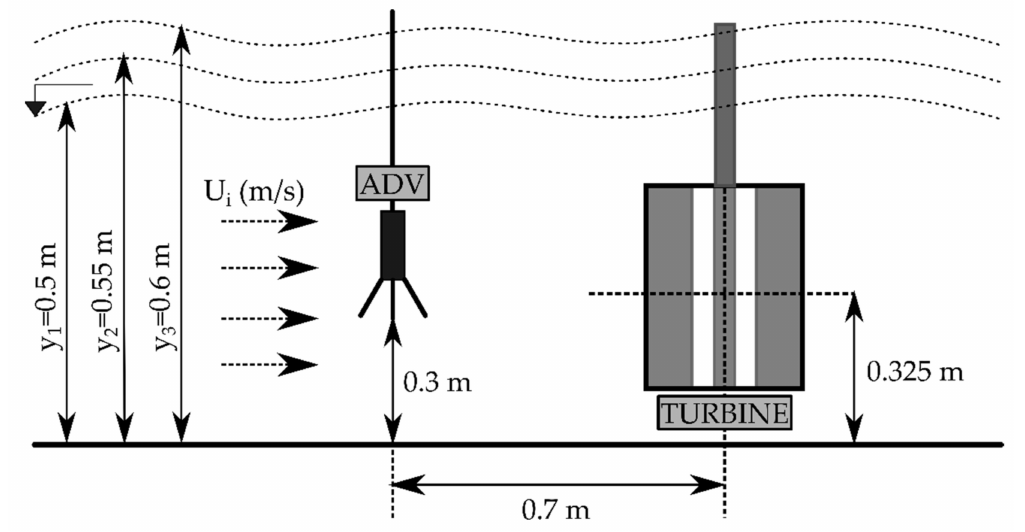
Figure 8. Diagram with the position of the different elements used in